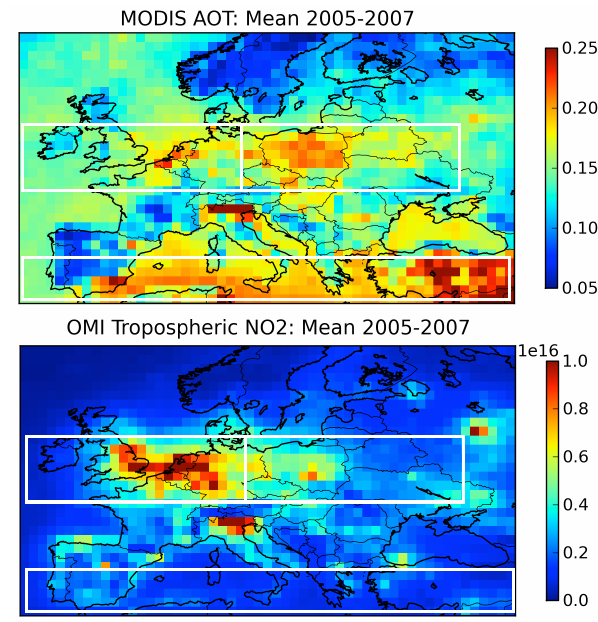
Fig. 1. Bottom panel: OMI tropospheric NO 2 in moleculescm − 2 . Top panel: MODIS AOT at 550nm. Both figures are averages over the period 2005–2007 and are on a 1 ◦ × 1 ◦ degree latitude longi- tude grid. Three areas are indicated in these images: an area over western Europe, an area over eastern Europe and an area over the Mediterranean